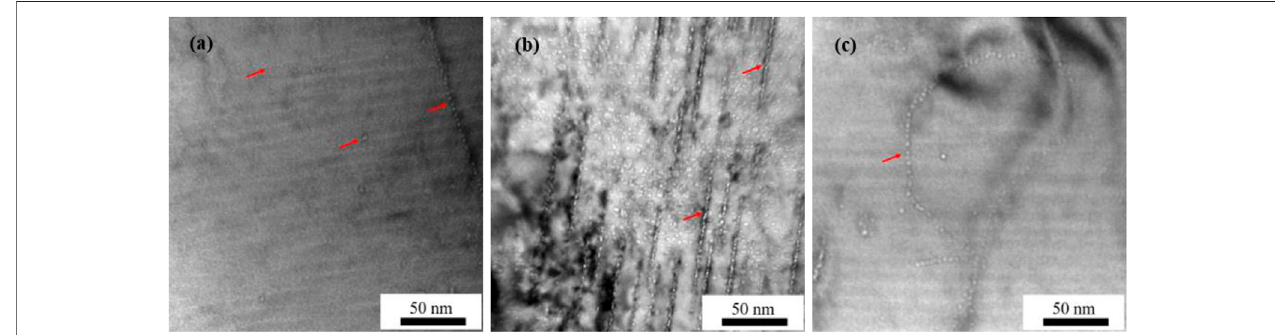
FIGURE3| TEMBFimagestakenunder < 110 > zoneaxisshowingthebubbledistribution indifferentregions: (A) inregion1,theredarrowsindicatesmallbubbles at the matrix and on the GBs, (B) in region 2, the red arrows indicate bubbles inside the plane of loops, and (C) in region 3, the red arrows indicate bubbles at the dislocation lines.